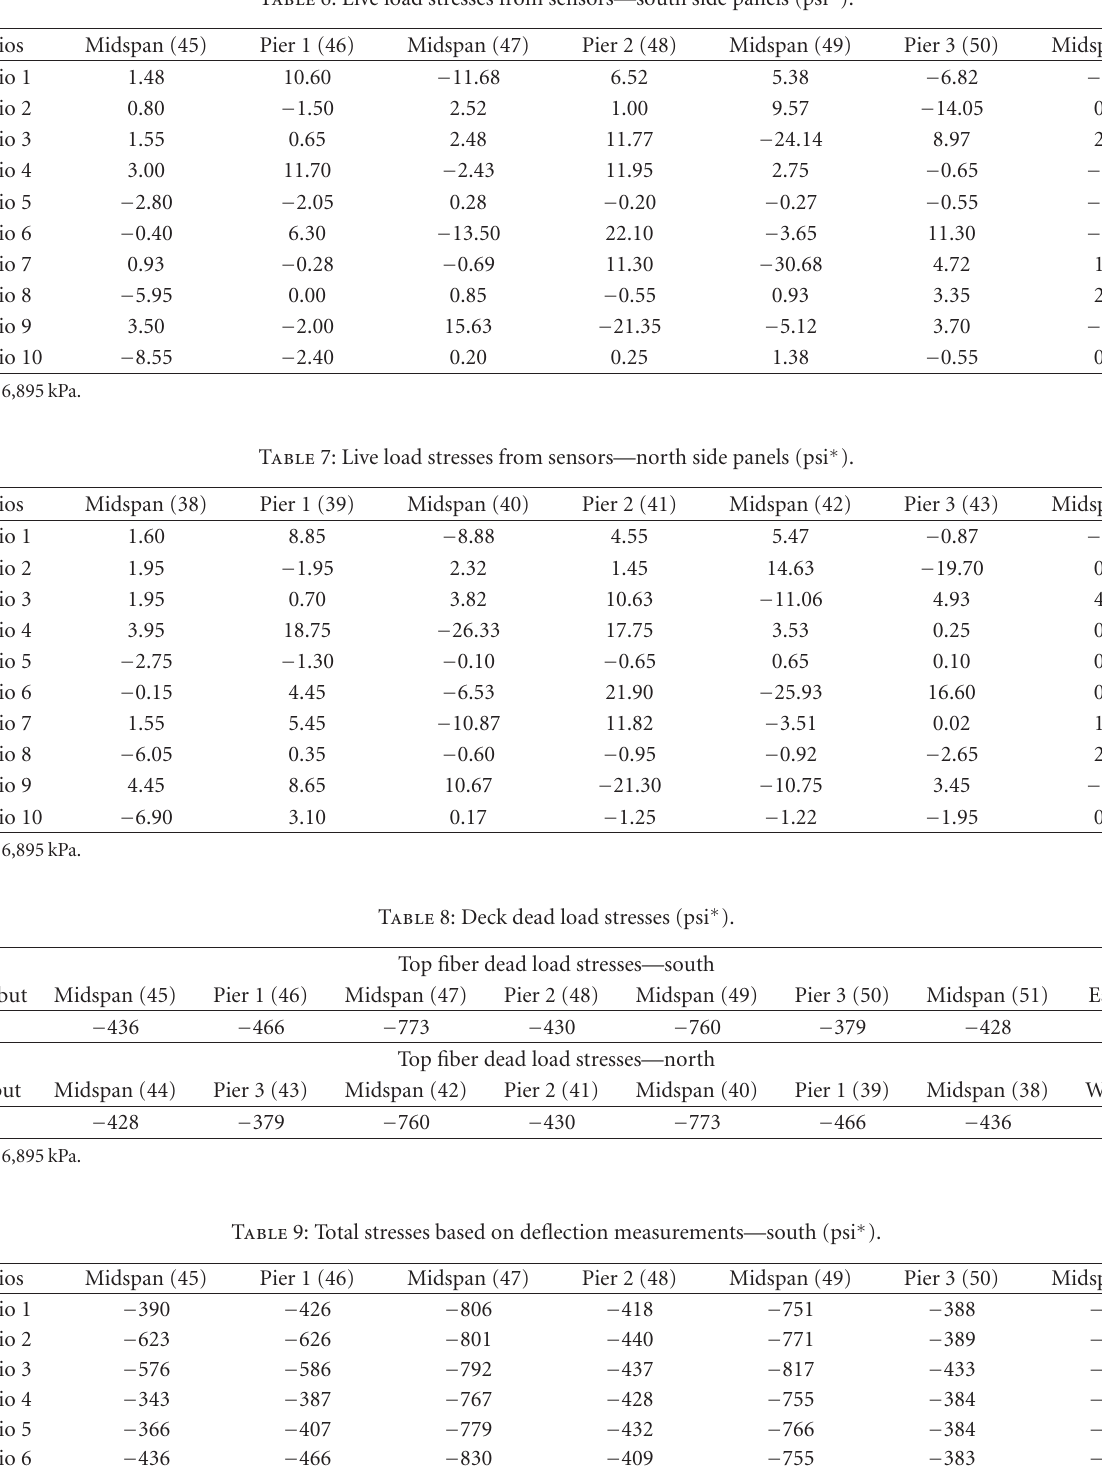
Table 6: Live load stresses from sensors—south side panels (psi ∗ ).